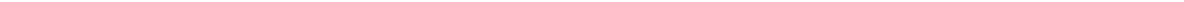
Fig. 1 sE-cad promotes angiogenesis in vitro and in vivo. a Cell migration assay of HUVEC treated with control (ctrl) or immunodepleted conditioned medium (CM) of Caov-3 and OV-90. Upper: Representative images of HUVEC migration. Lower: Quanti fi cation of the percentage change of the number of migrated cells. Bar, 100 μ m. b Proliferation assay of HUVEC treated with control (ctrl) or immunodepleted conditioned medium (CM) of Caov-3 and OV- 90 in the presence or absence of E-cadherin neutralizing antibodies, HECD-1 (100 μ g mL − 1 ). c Permeability analysis of HUVEC measured by the percentage change of FITC – dextran fl ux (excitation 485 nm, emission 535 nm) treated with control (ctrl) or immunodepleted conditioned medium (CM) of Caov-3 and OV-90. d Tube formation assay of HUVEC treated with control (ctrl) or immunodepleted conditioned medium (CM) of Caov-3 and OV-90. Upper: Representative images of HUVEC tube formation assay. Lower: Quanti fi cation of the percentage change of the number of branching points. Bar, 100 μ m. e In vivo Matrigel plug implant model using C57/BL6 mice subcutaneously injected with control (ctrl) or immunodepleted conditioned medium (CM) of Caov-3 and OV-90. In vivo neovascularization is measured by the Drabkin ’ s reagent kit after 7 days. Upper: Representative images of excised Matrigel plug. Lower: Quanti fi cation of the percentage change in hemoglobin content. Bar, 5 mm. For in vivo Matrigel plug model, n = 6 per group, and were conducted twice. For the other assays, n = 3 per group, all experiments were repeated three times. Error bar indicates SD of the mean. * P < 0.05, ** P < 0.01 versus untreated control using one-way analysis of variance followed by Tukey ’ s least signi fi cant difference post hoc